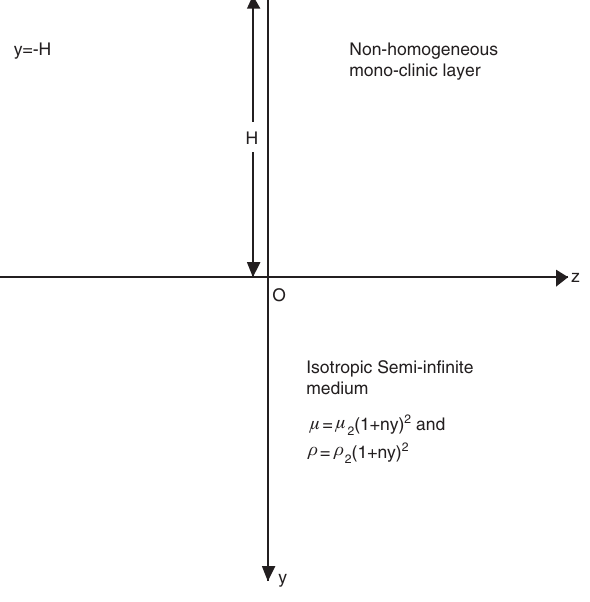
Figure 1: The geometry of the